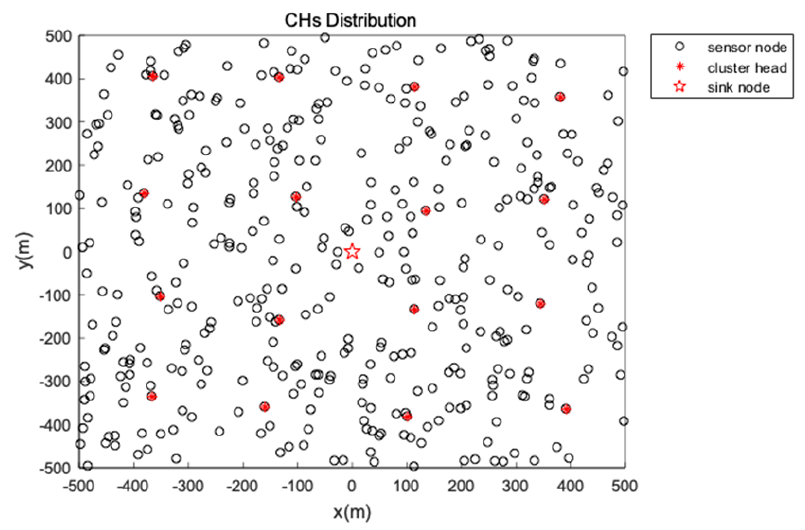
Figure 4. First period CHs distribution.